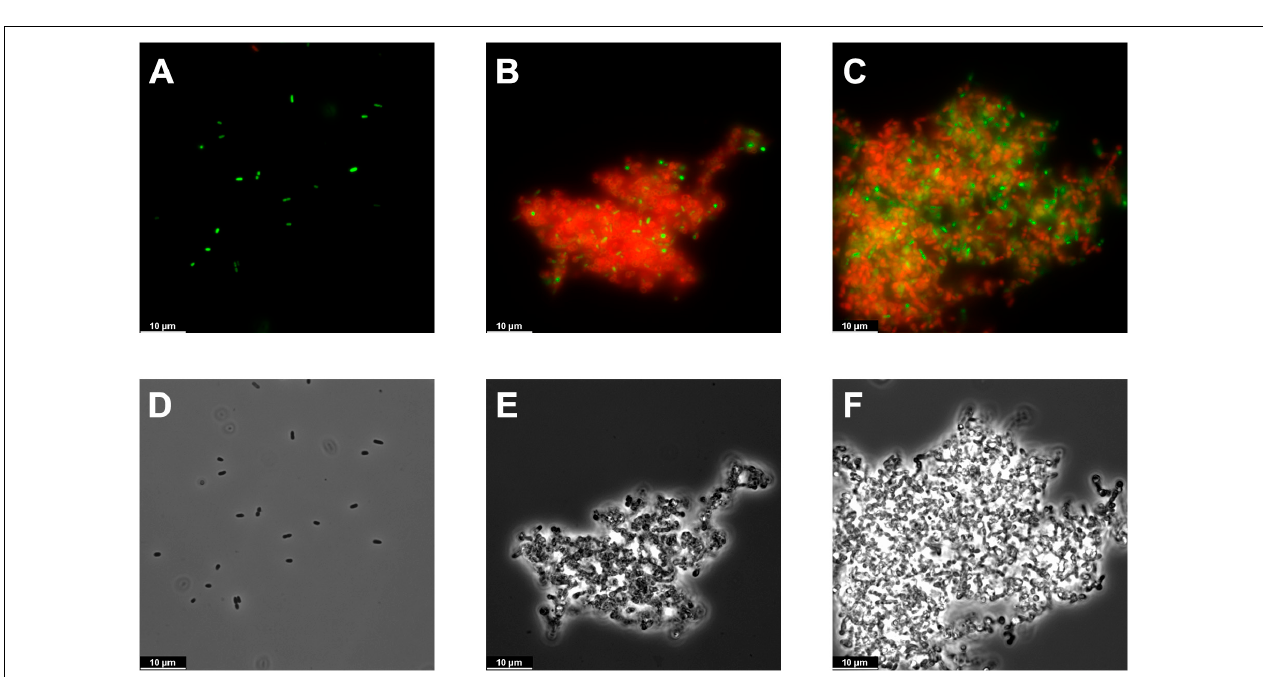
FIGURE 6 | Microscopy images of PAO1 suspensions. (A–C) Fluorescence microscopy images of the bacterial suspensions untreated (A) or treated for 2 h with 10 µ M Pae87 (B) or 10 µ M Ppl65 (C) and stained with the BacLight kit. (D–F) Corresponding phase contrast images.